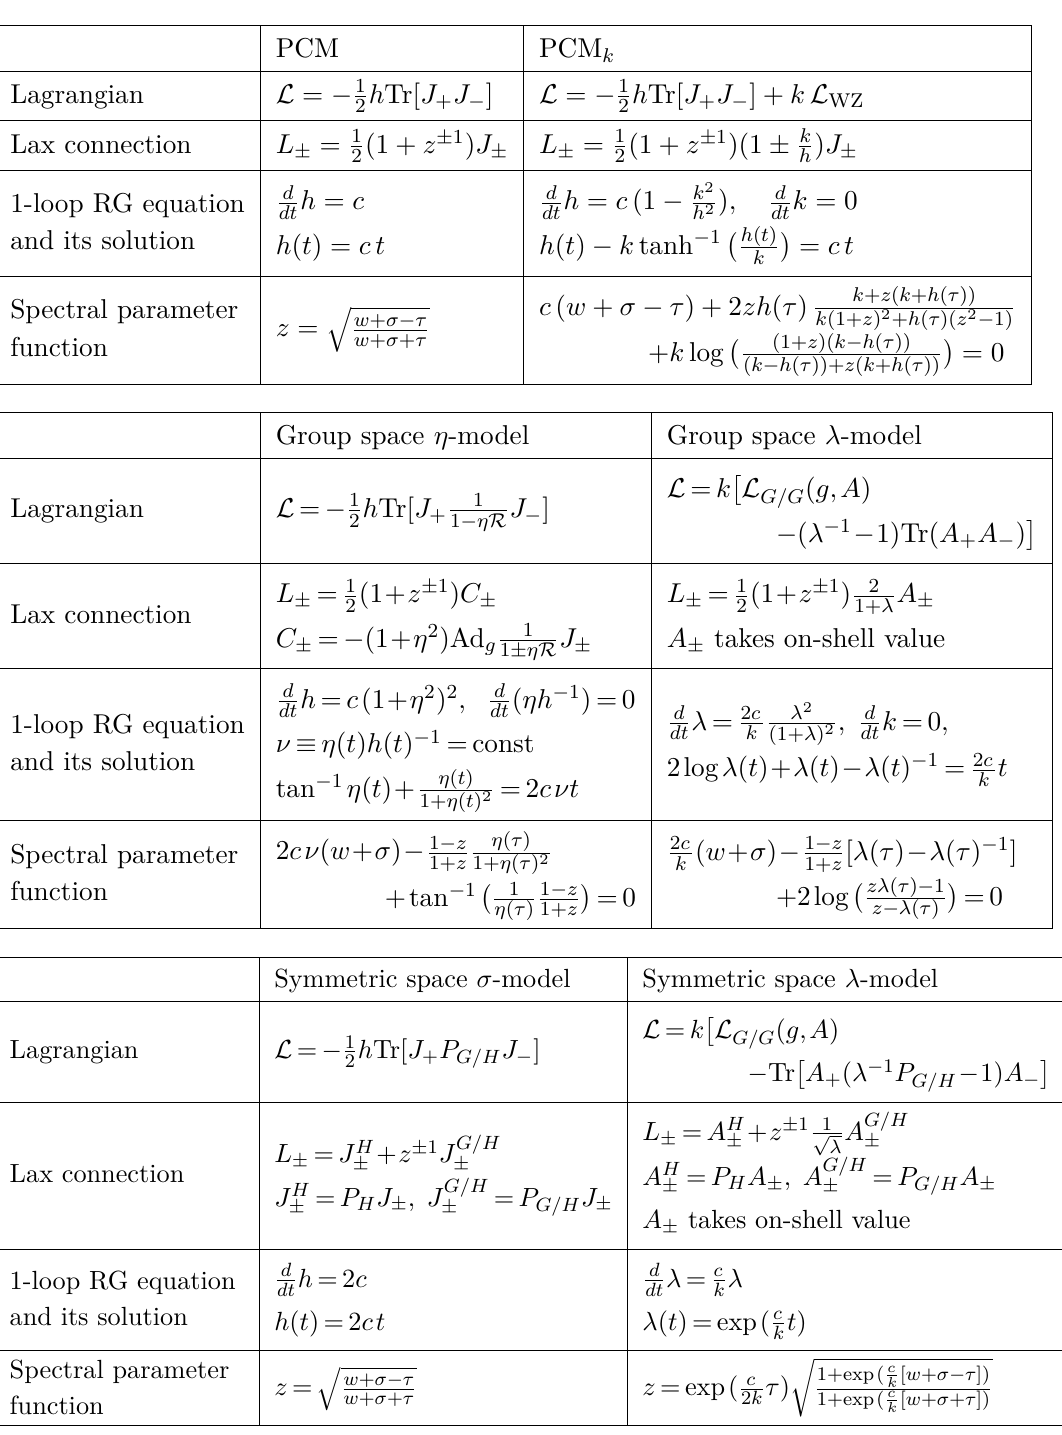
Table 1 . Examples of integrable σ -models and their time-dependent generalizations. t is the RG time which is replaced by the 2d time τ in the couplings entering the Lagrangian b L in